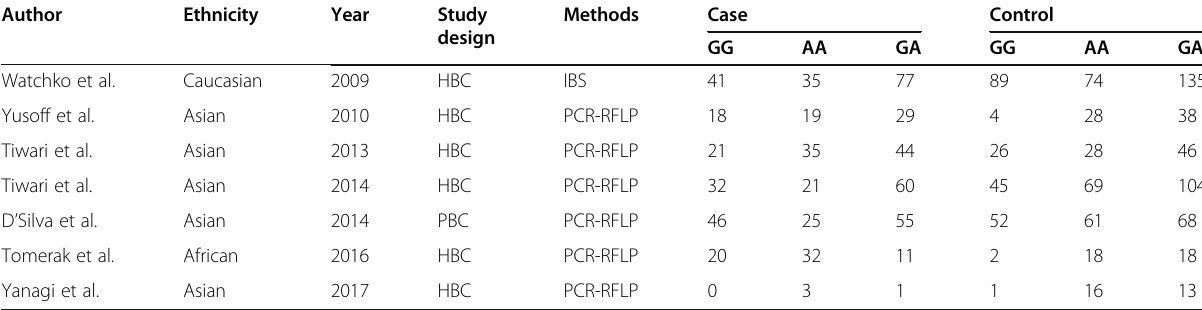
Table 1 Basic information of the original articles included in this meta-analysis Author